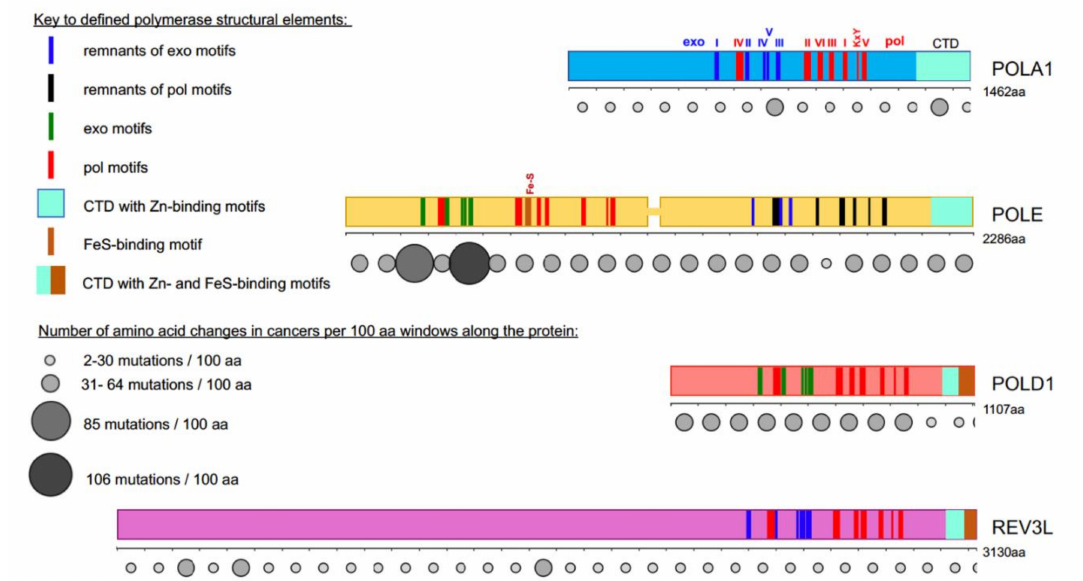
Figure 1. Most cancer-associated mutations a ff ect the catalytically active half of POLE. Colored bars represent the main subunits of DNA pols, a catalytic subunit of pol α , POLA1, in light blue; of pol ε , POLE, in yellow; of pol δ , POLD1, in red; and pol ζ , REV3L, in purple. Note that POLE is a tandem of active pol ( N -terminal half) and inactive pol (C-terminal half) [5,6]. Evolutionarily conserved motifs characteristic for all exonuclease (exo) domains, are labeled I-V in green and pol domains are labeled I-VI and KxY in red [5–12]. The order of the motifs along all four proteins is the same, but they occupy di ff erent parts of the whole protein. For example, REV3L has a very long N -terminal part not related to pols. In POL1, REV3L, and the C-terminal half of POLE, the exonuclease motifs are inactivated during evolution; they are shown in blue. Inactivated pol motifs in the C-terminal half of POLE are shown in black. The key for these and other elements of the pol primary structure is in the left upper quarter of the figure. Rows of circles of di ff erent sizes and shades of grey below the catalytic pol subunits represent the number of missense mutations found in tumors along the protein regions in 100 amino acid increments. Variants were collected from the cBioPortal database from a curated non-overlapping collection of tumor genomes (https: // www.cbioportal.org / (cbioportal.org)). A guide explaining the relation between size and intensity of grey to the number of mutations found in the database in the 100 amino acids interval is on the left lower quarter of the